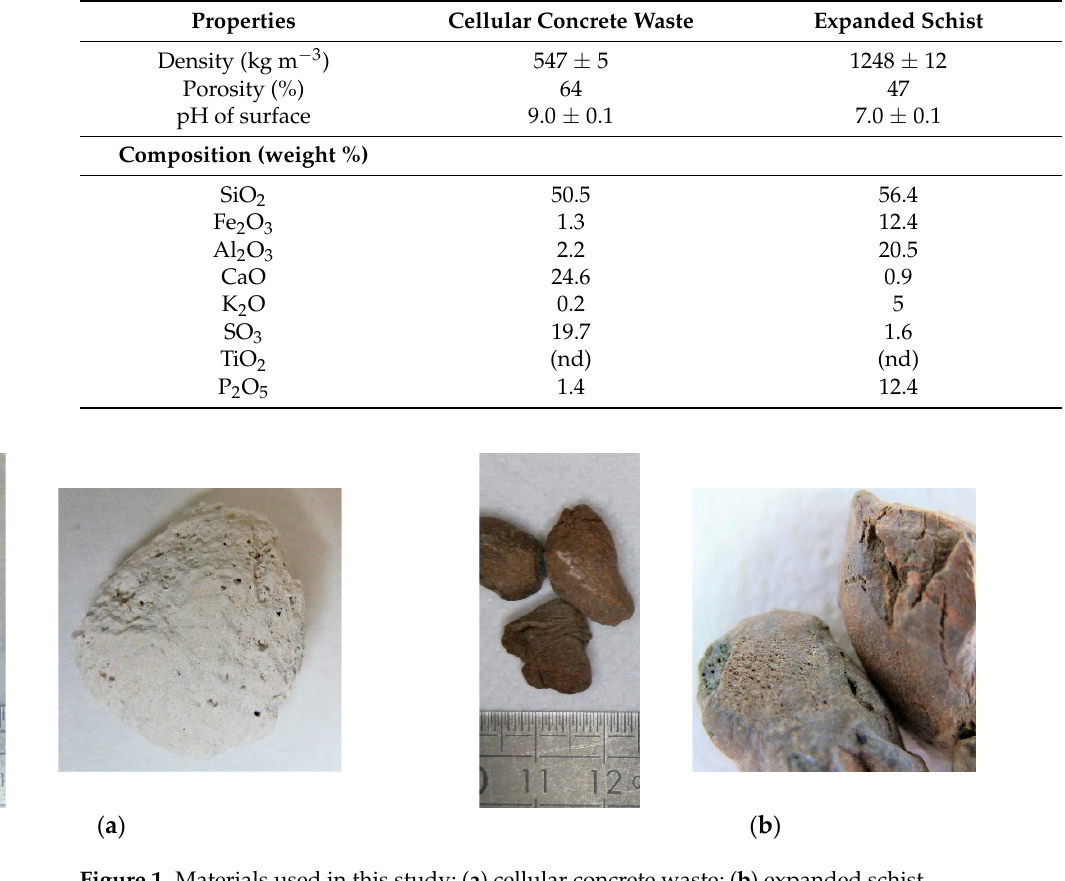
Table 1. Physico-chemical properties and composition of materials (Adapted with permission from Refs. [23,25]).